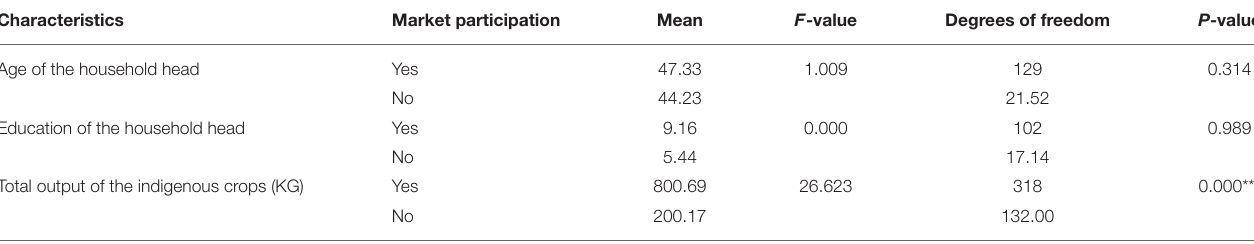
TABLE 5 | Demographic characteristics of smallholder farmers that were involved in the production of indigenous crops in Limpopo and Mpumalanga provinces, South